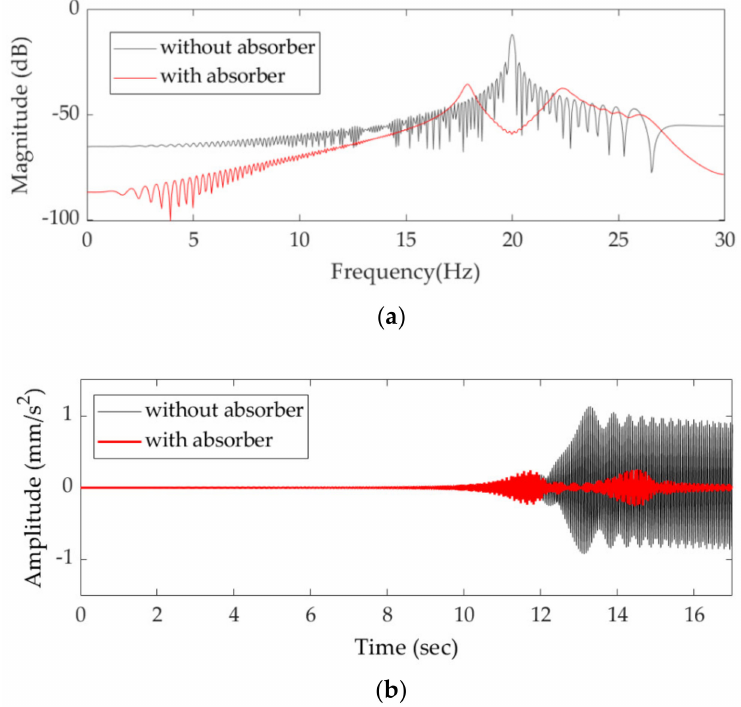
Figure 5. Numerical simulation results of single degrees of freedom vibration absorber. ( a ) Frequency response, ( b ) Time response